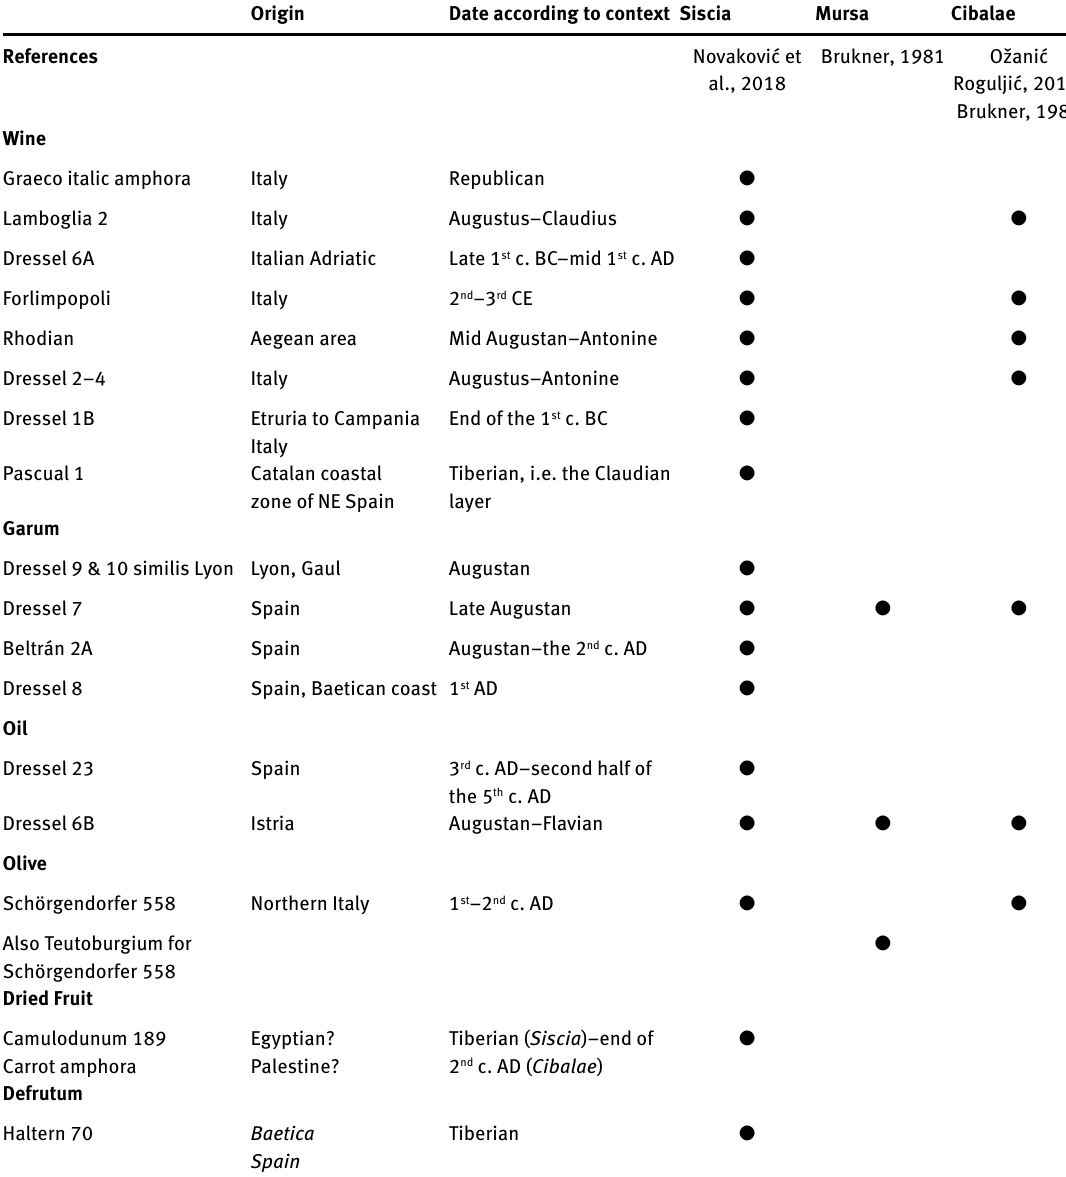
Figure 3: Pithoi storage vessel, 2 nd century AD, found at Cibalae, Siscia and Mursa. Table 1: Amphorae that would have contained foodstuff found in Roman Siscia (Sisak), Mursa (Osijek) and Cibalae (Vinkovci),